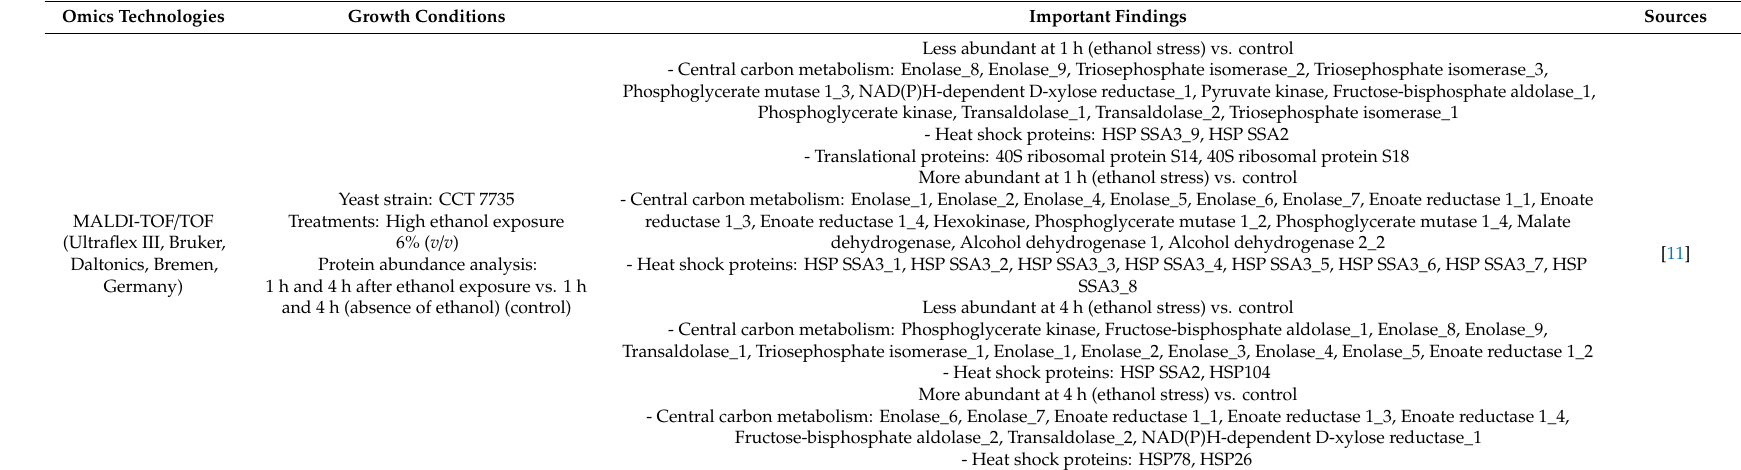
Abbreviation of gene / enzyme in the Table 1: RAG5, hexokinase; RAG2, glucose-6-phosphate isomerase; FBA1, fructose-bisphosphate aldolase; GAP3, glyceraldehyde-3-phosphate dehydrogenase 3; GAP1, glyceraldehyde-3-phosphate dehydrogenase 1; PGK, phosphoglycerate kinase; GPM1, phosphoglycerate mutase 1; GPM2, probable phosphoglycerate mutase YOR283W; GPM3, phosphoglycerate mutase 3; ENO, enolase; PYK1, pyruvate kinase; LAT1, acetyltransferase component of pyruvate dehydrogenase complex; PYC2, pyruvate carboxylase; ACO1, aconitate hydratase; ACO2b, aconitate hydratase; LSC2, succinyl-CoA ligase subunit β ; PFK1, phosphofructokinase 1; GPD1, glycerol-3-phosphate dehydrogenase 1; GPD2, glycerol-3-phosphate dehydrogenase 2; TDH1, glyceraldehyde-3-phosphate dehydrogenase 1; TDH2, glyceraldehyde-3-phosphate dehydrogenase 2; TDH3, glyceraldehyde-3-phosphate dehydrogenase 3; RHR2, glycerol-3-phosphatase 1; TPI1, triose phosphate isomerase; PDX1, pyruvate dehydrogenase; ACS2, acetyl-CoA synthetase 2; ALD4, aldehyde dehydrogenase; CIT1, citrate synthase; MDH1, malate dehydrogenase 1; MDH2, malate dehydrogenase 2; MDH3, malate dehydrogenase 3; FUM1, fumarate hydratase; IDP1, isocitrate dehydrogenase 1; KGD1, 2-oxoglutarate dehydrogenase E1 component; KGD2, dihydrolipoyllysine-residue succinyltransferase component of 2-oxoglutarate dehydrogenase complex; GAL1, galactokinase; GAL7, galactose-1-phosphate uridylyltransferase; GAL10, bifunctional protein; ADH, alcohol dehydrogenase; ADH1, alcohol dehydrogenase 1; ADH2, alcohol dehydrogenase 2; ADH3 alcohol dehydrogenase 3; ADH4b, alcohol dehydrogenase 4; ADH6, NADP-dependent alcohol dehydrogenase 6; ZWF, glucose-6-phosphate 1-dehydrogenase;